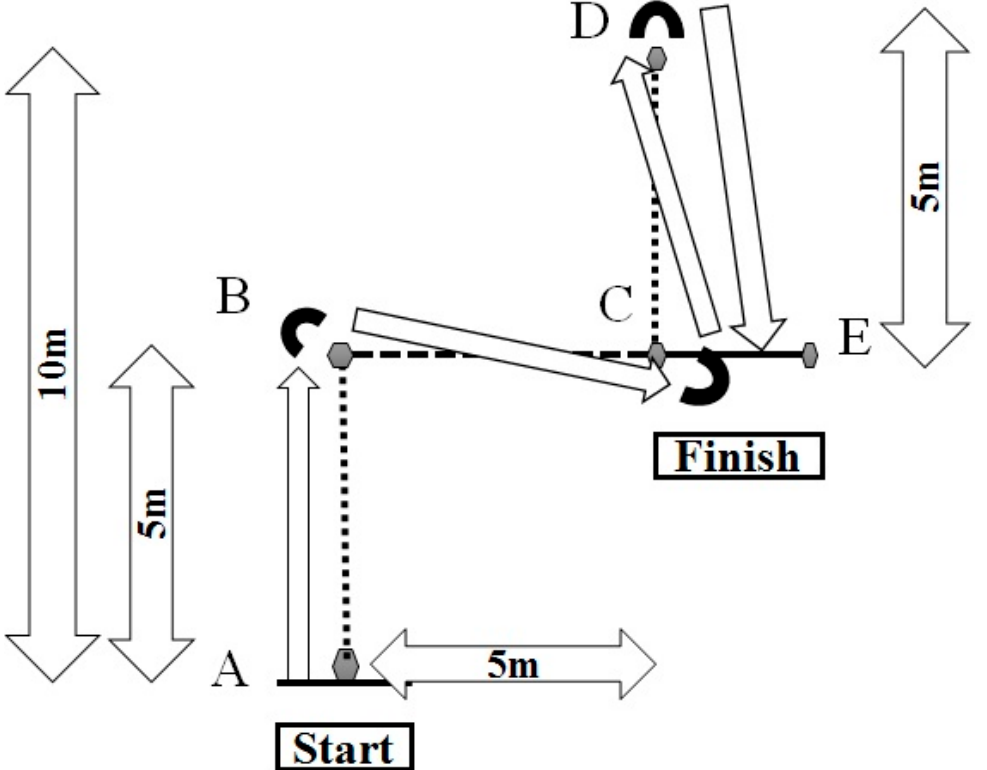
Figure 3. Design of the sprint 4 × 5 m (S4 × 5 m). A and E are start and finish lines respectively. B, C and D are lines of change of